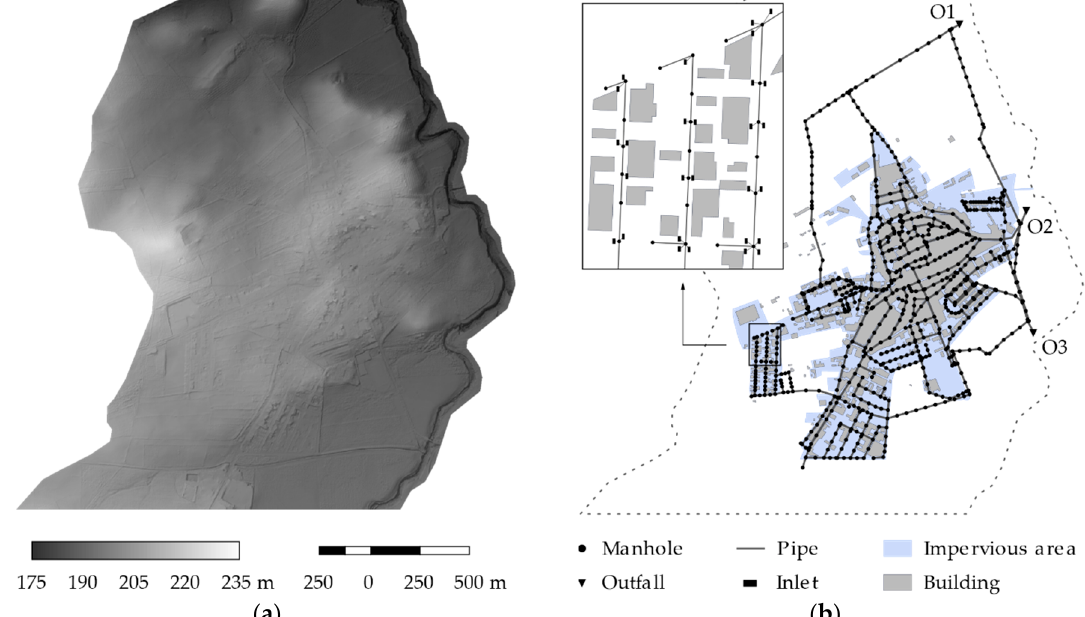
Figure 11. ( a ) DEM of the study area; ( b ) sewer network of the urban settlement.